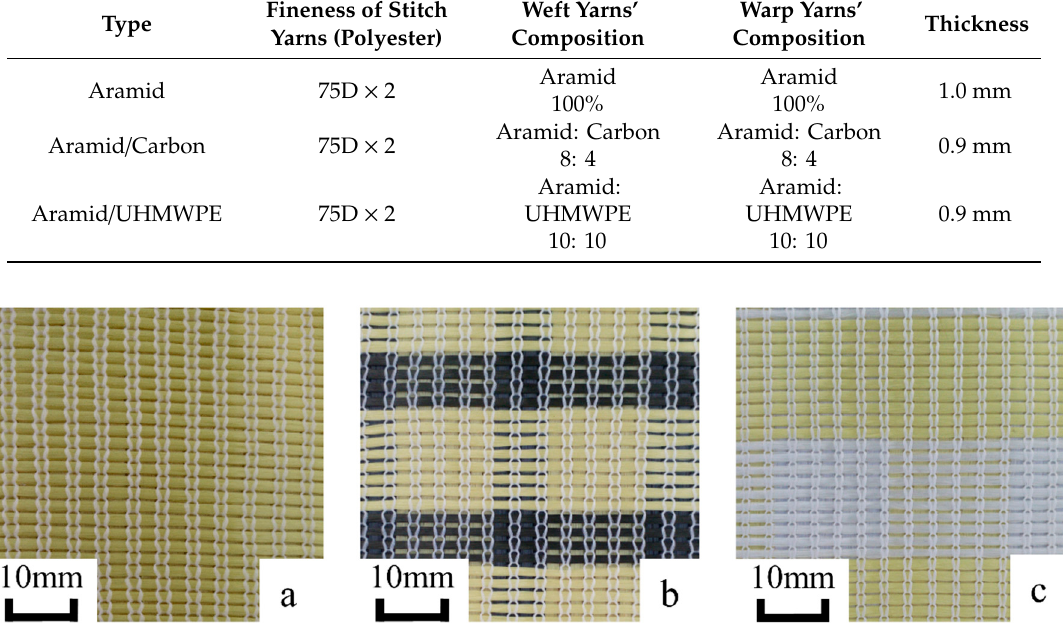
Figure 2. Three types MBWK fabrics: ( a ) Aramid; ( b ) Aramid/carbon; ( c ) Aramid/UHMWPE. Table 2. Parameters of three types MBWK fabrics.